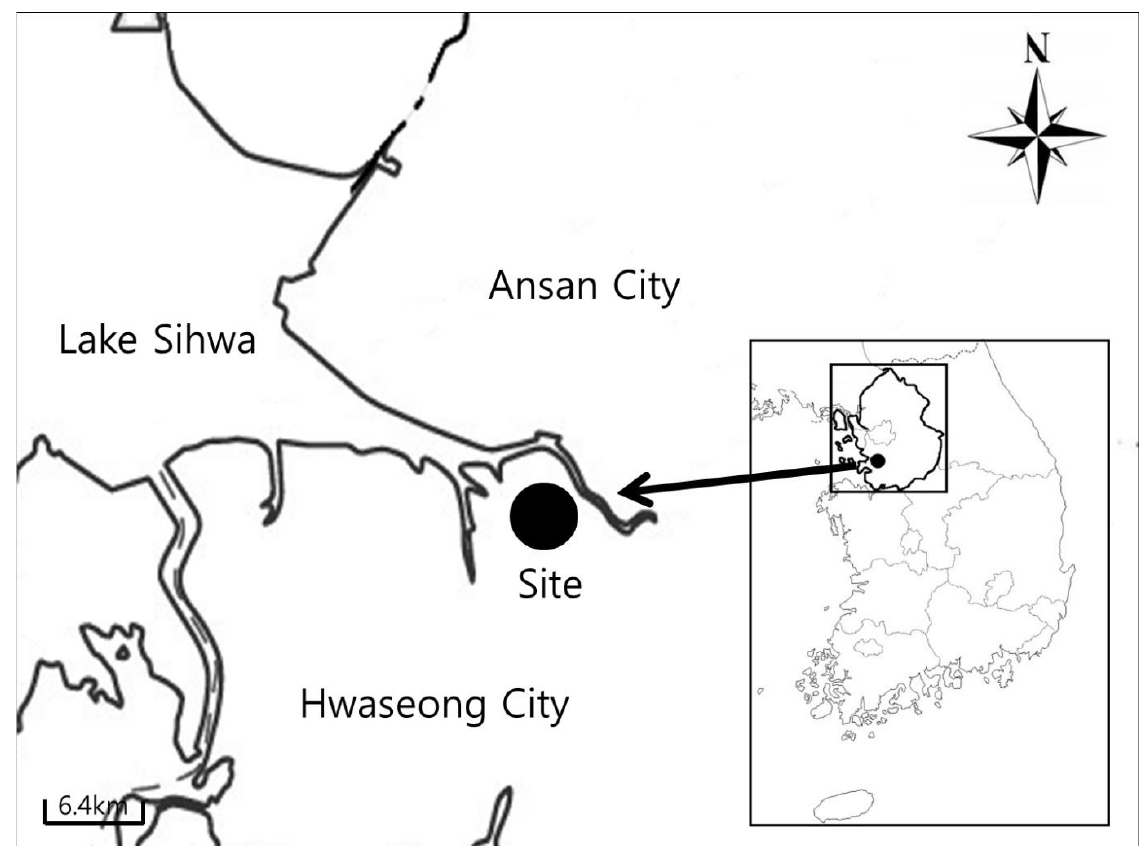
Figure 1. Map of study site in South Korea.